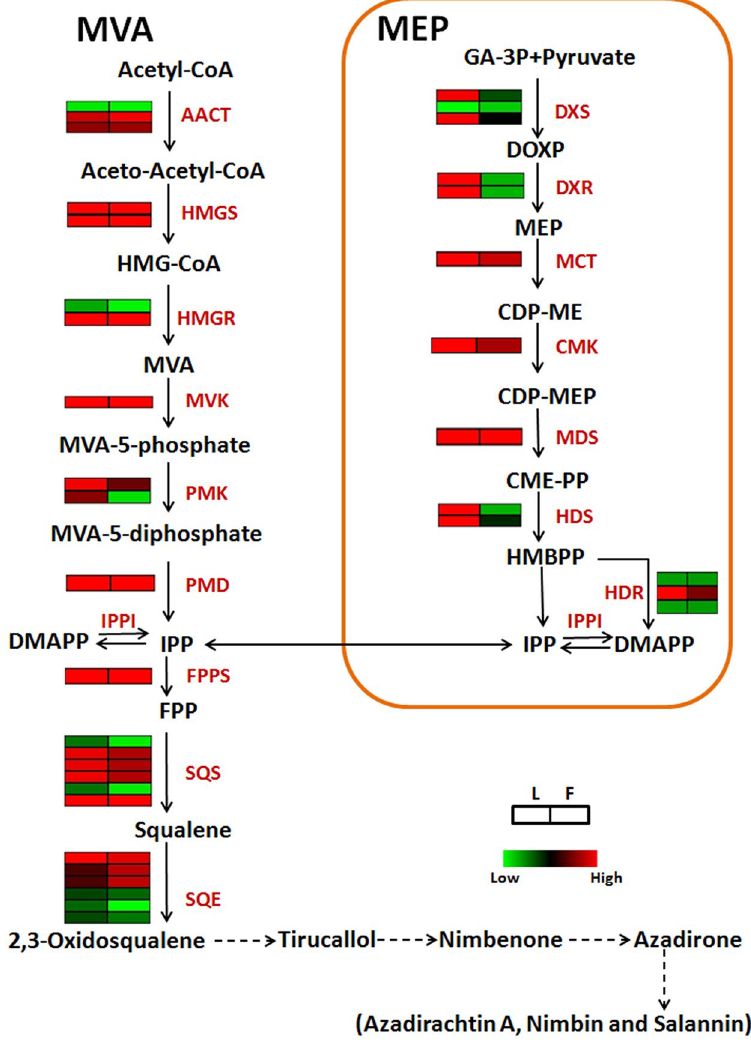
Figure 3. Putative pathway for tetranortriterpenoid biosynthesis from Azadirachta indica . Name of the enzymes catalyzing biochemical steps are shown between the reactions and expression of unigenes encoding these enzymes in leaf and fruit is shown by heatmap. Broken arrows represent putative steps involving enzymes involved in secondary modifications. AACT, acetyl CoA acetyltransferase; HMGS, 3-hydroxy-3-methylglutaryl- coenzymeA synthase; HMGR, 3-hydroxy-3-methylglutaryl-coenzymeA reductase; MVK, mevalonate kinase; PMK, phosphomevalonate kinase; PMD, phosphomevalonate decarboxylase; DXS, 1-deoxy-D-xylulose- 5-phosphate synthase; DXR, 1-deoxy-D-xylulose-5-phosphate reductoisomerase; MCT, 2-C-methyl-D- erythritol-4-phosphate cytidylyl transferase; CMK, 4-diphosphocytidyl-2-C-methyl-D-erythritol kinase; MDS, 2-C-methyl-D-erythritol-2,4-cyclodiphosphate synthase; HDS, 4-hydroxy-3-methylbut-2-enyldiphosphate synthase; HDR, 4-hydroxy-3-methylbut-2-enyldiphosphate reductase; IPPI, isopentenyl diphosphate isomerase; FPPS, farnesyl diphosphate synthase; SQS, squalene synthase; SQE, squalene